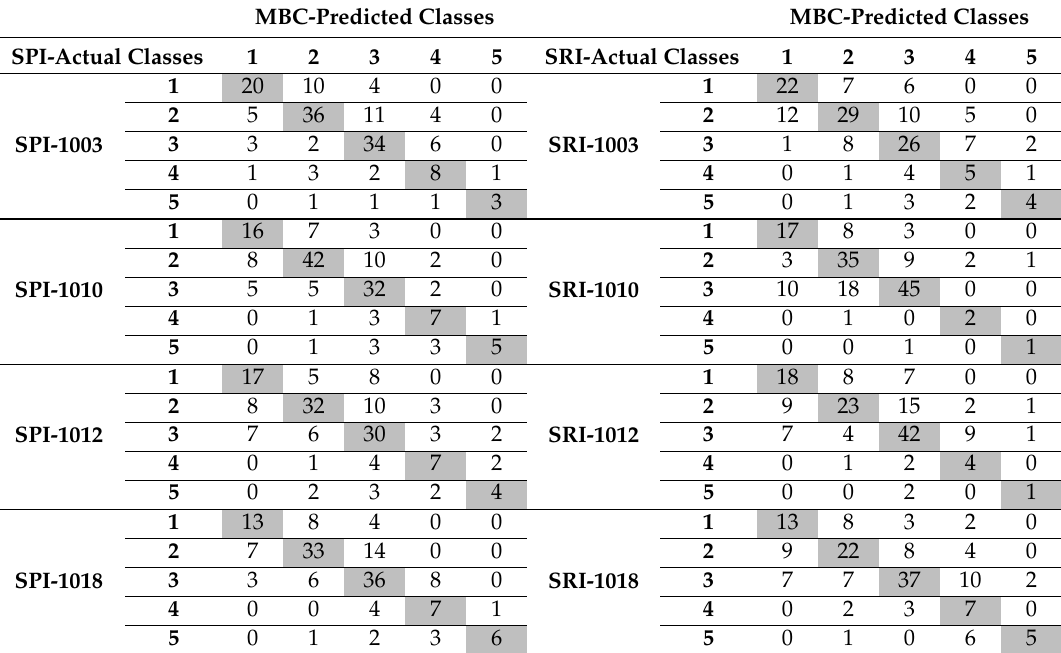
Table 2. The frequency of each drought class classified by the MBC and standardized drought